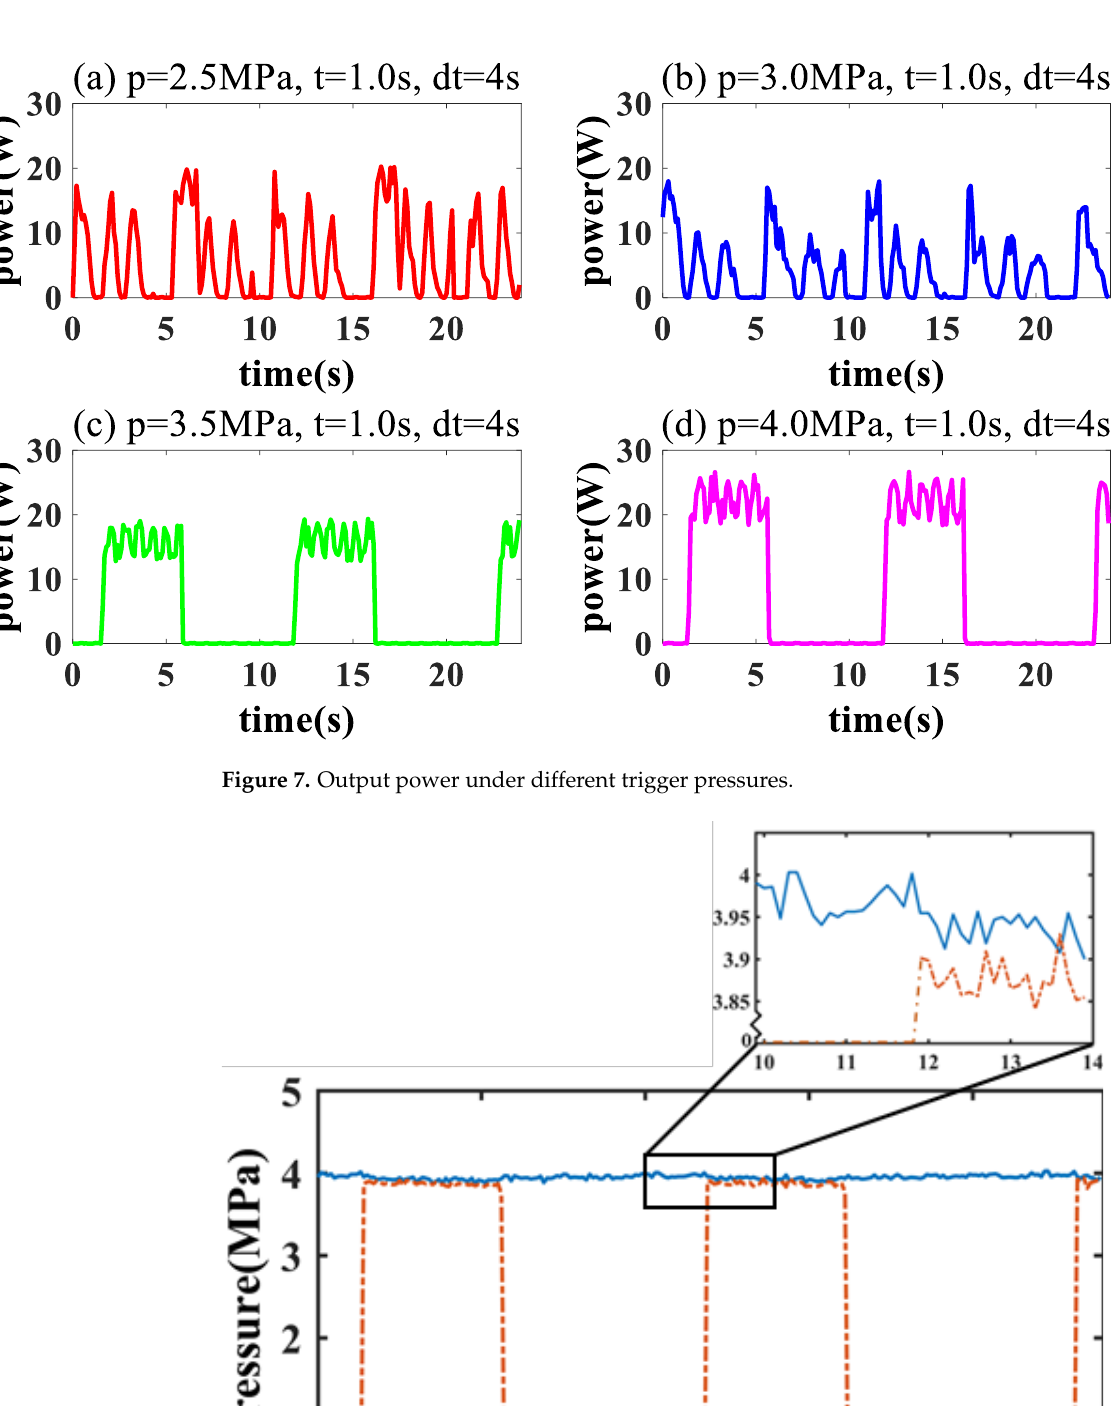
Figure 9. The average values of output power and power fluctuation index under different trigger pressure conditions. It can be seen from Figure 9 that the average power has a tendency of decreasing first and then increasing. The average power reaches a low point at a trigger pressure of 3.0 MPa. As the trigger pressure increases, the power fluctuation index gradually drops to its lowest point. When the trigger pressure is 4 MPa, the average output power reaches the maximum and the power fluctuation index is the minimum, indicating that the output energy of the hydraulic PTO system is large and that the power conversion process is stable under this condition. 3.3. Influence of Delay Time on Output Power The trigger pressure p is kept at 3.5 MPa, and the open state duration dt is kept at 4.0 s to analyze the influence of delay time t on the output power. The time history curves of output power obtained from the experiments are shown in Figure 10.